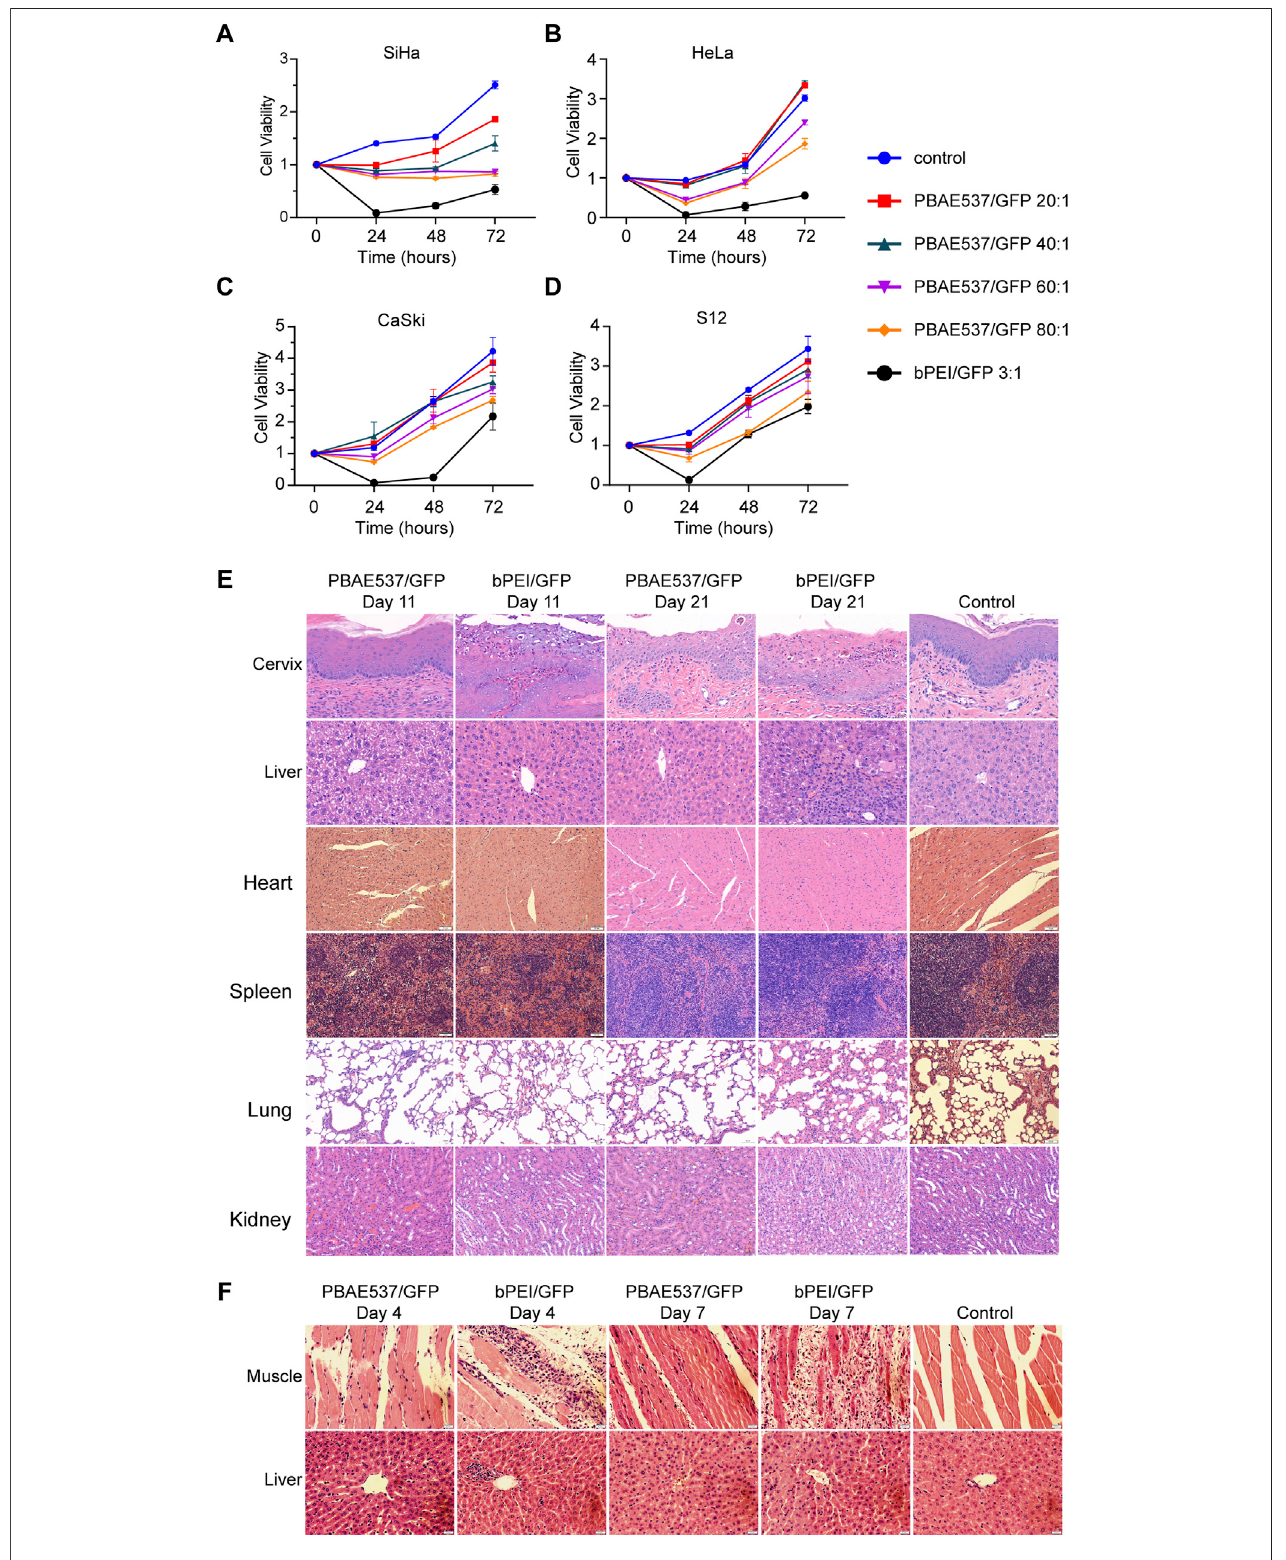
FIGURE4| Toxicityanalysisofnanoparticlesincelllinesandmouseorgans. (A – D) ThetoxicityofPBAE537/GFPnanoparticleswithdifferentmassratios(20:1,40: